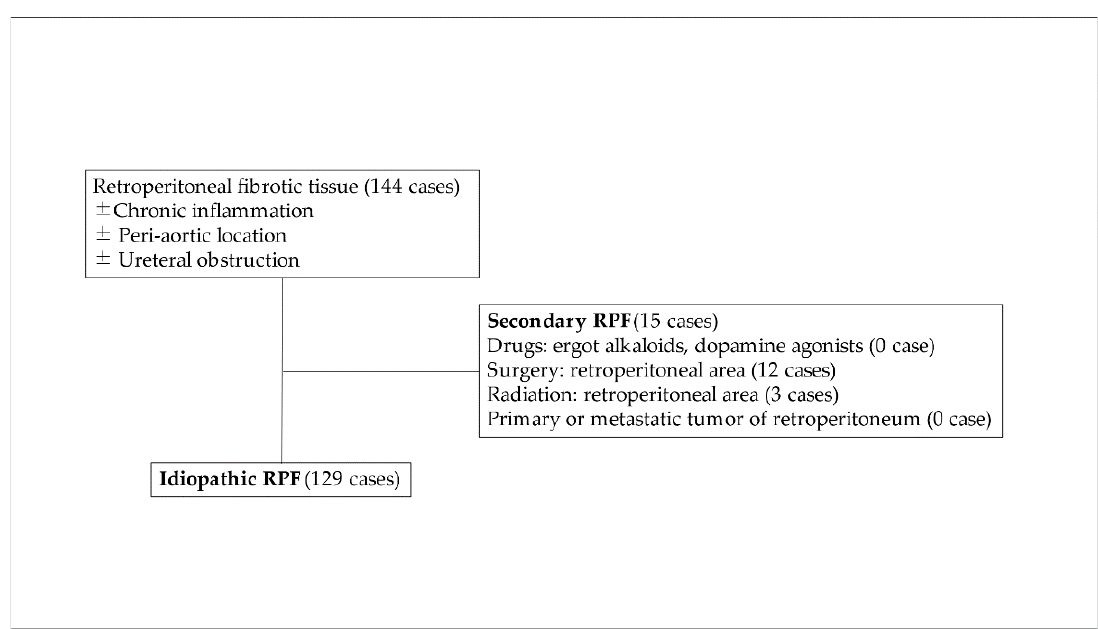
Figure 1. Classification of retroperitoneal fibrosis, and selection of study cohort. A total of 144 cases were enrolled, and 15 cases were classified as secondary RPF. Patients with idiopathic RPF were analyzed in this study.